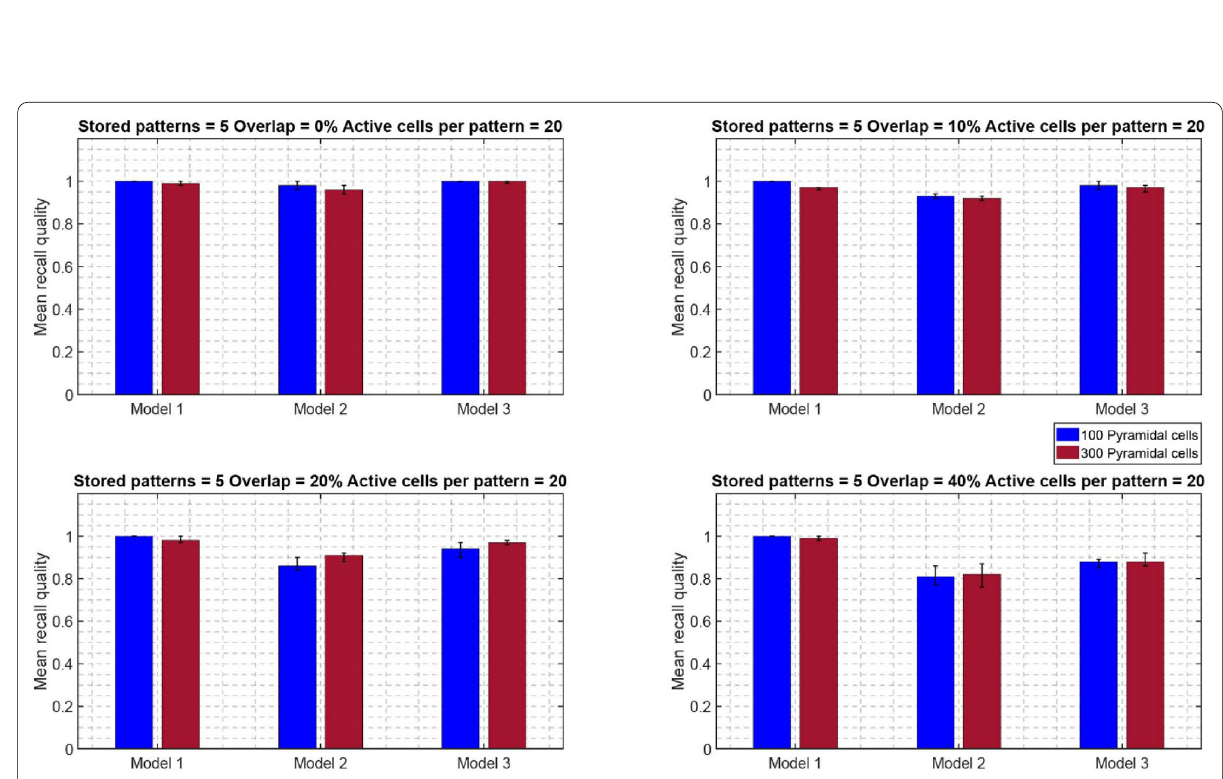
Fig. 14 Comparison of mean recall quality of ‘model 1’, ‘model 2’, and ‘model 3’ as a function of network size (100 PCs vs 300 PCs) for five stored patterns, 20 active cells, and different % pattern